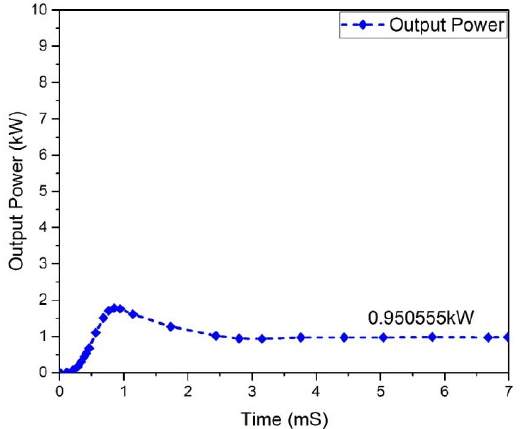
Figure 24. Output Power of Flyback boost converter (Si ‐ MOSFET).